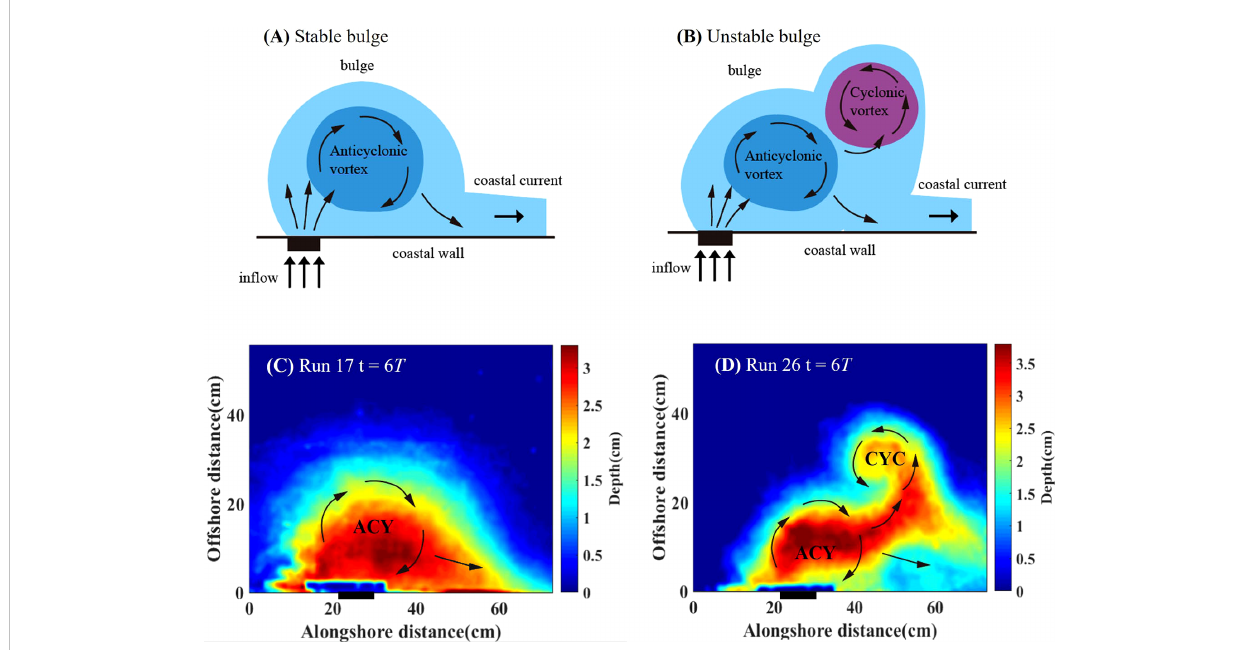
FIGURE 5 Schematics (top) and typical depth fi eld (bottom) of stable plumes (left) and unstable plumes (right). (A, B) are schematic representations of the bulge. (C, D) are depth fi elds of the bulge at t = 6 T . Black arrows in each panel indicate fl ow direction, while ACY and CYC represent anticyclonic vortex and cyclonic vortex,